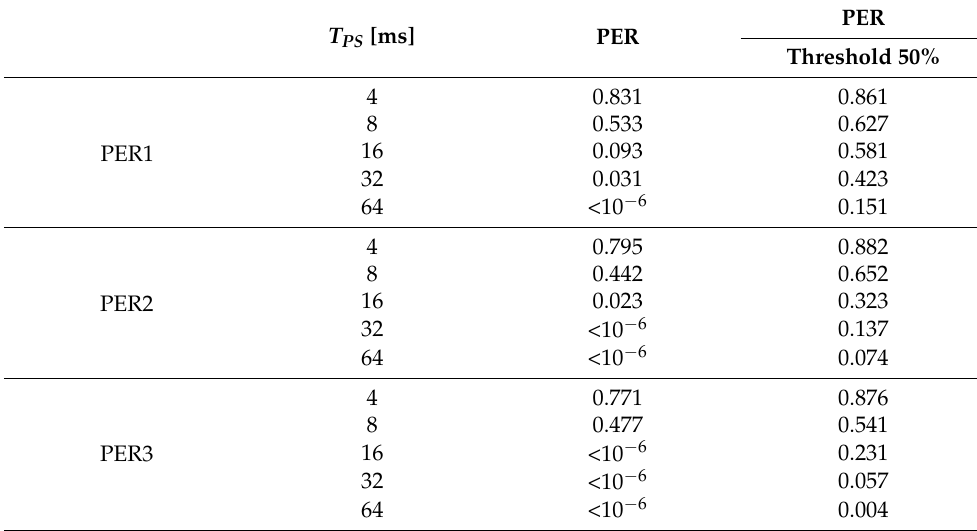
Table 7. Preamble Error Rate (PER) values for different values of T PS